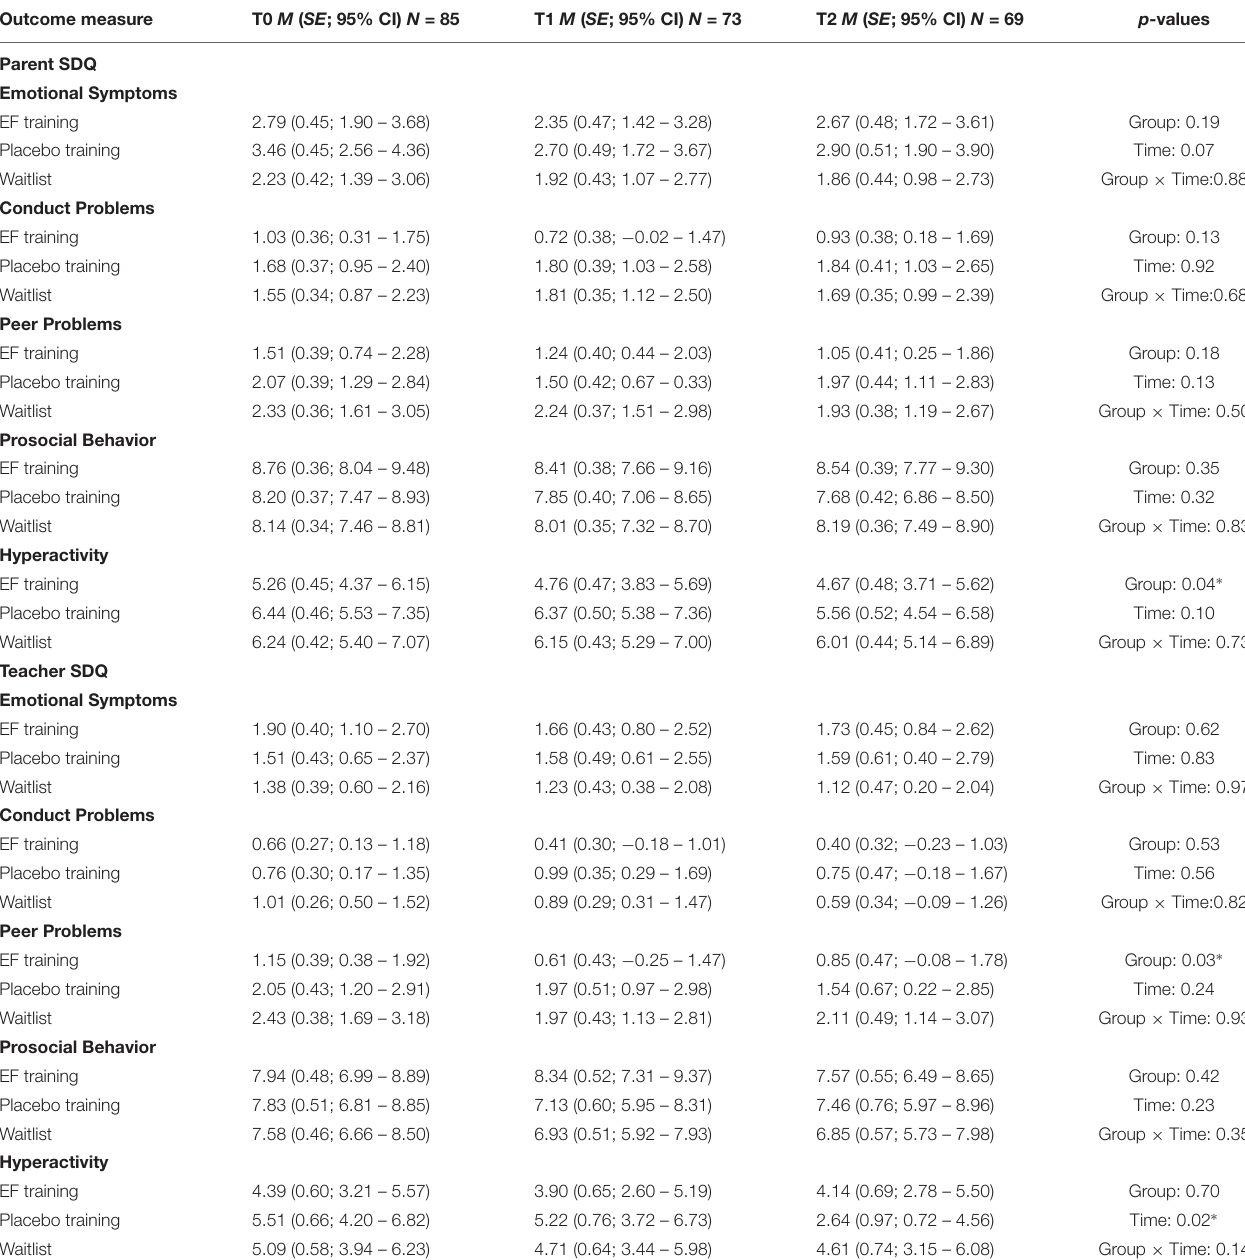
TABLE 4 | Baseline and follow-up data on the Strengths and Difficulties Questionnaire according to parents and teachers for the three treatment groups. Outcome